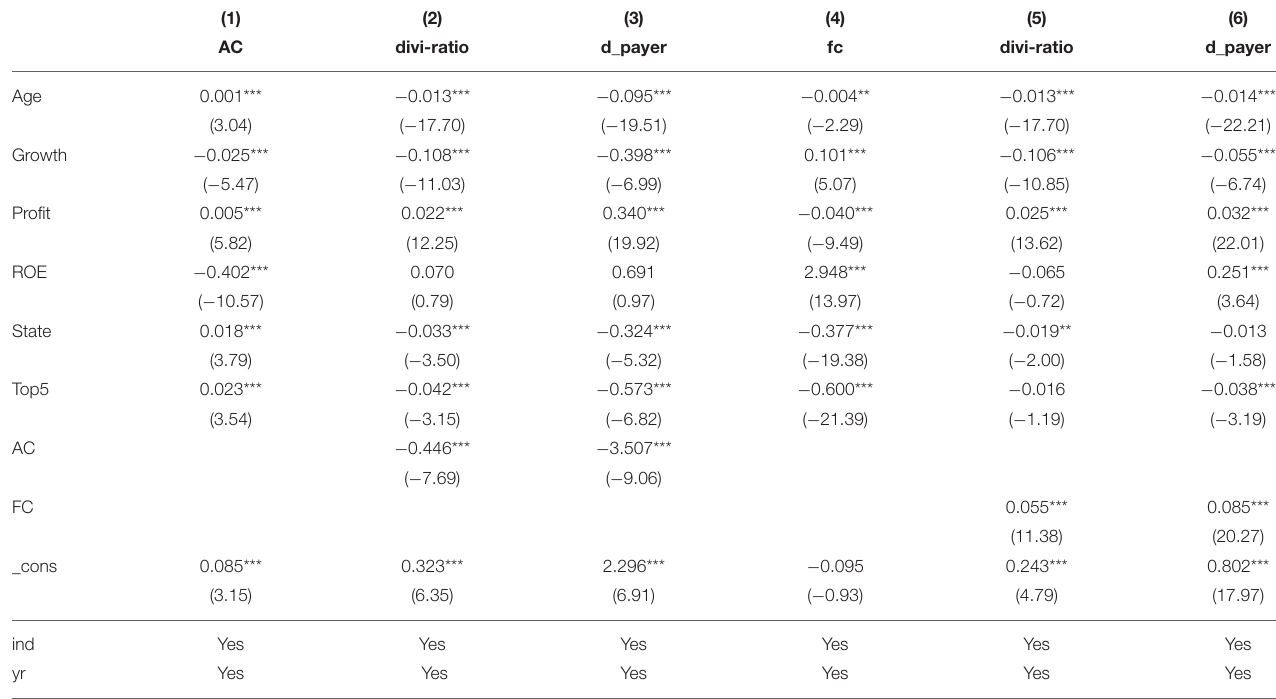
TABLE 6 | The mechanism test of supplier concentration acts on cash dividend payment tendency and dividend payment